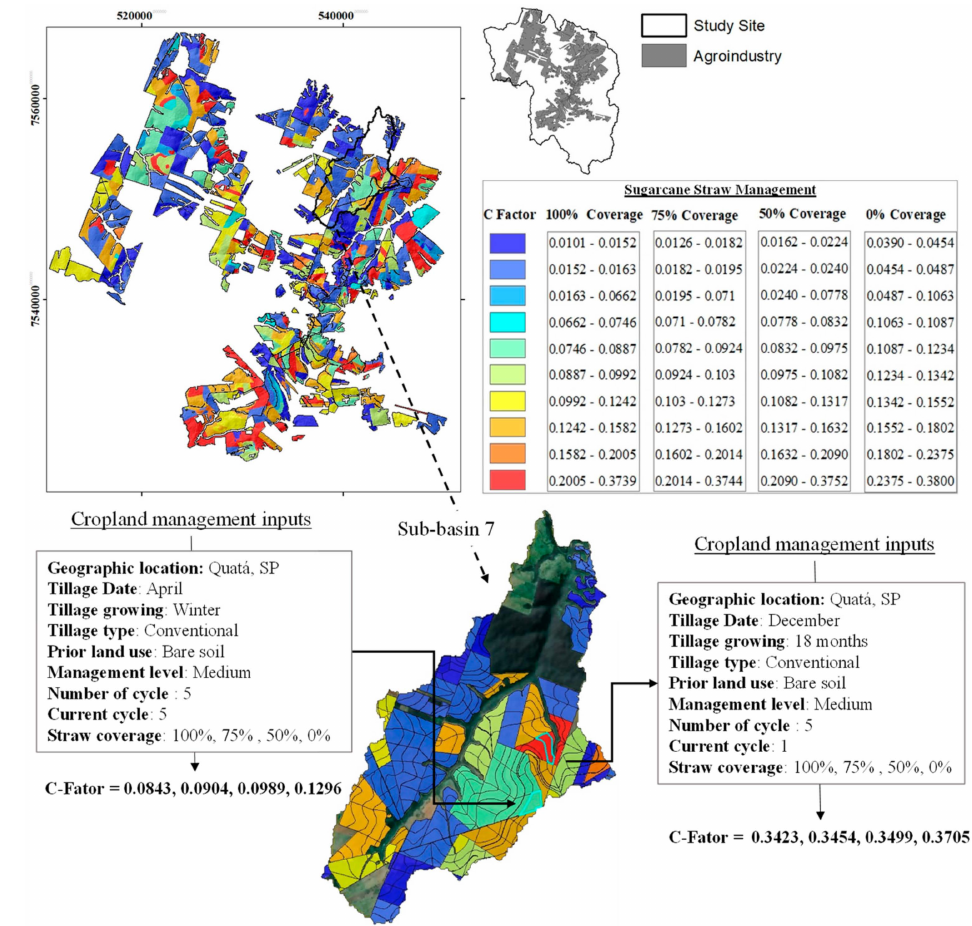
Figure 10. C-Factor of the agroindustry under 100% sugarcane straw coverage, 50% coverage, 75% coverage, and no coverage, and the sub-basin 7 representing two cover management input data in each arable cropland plot.